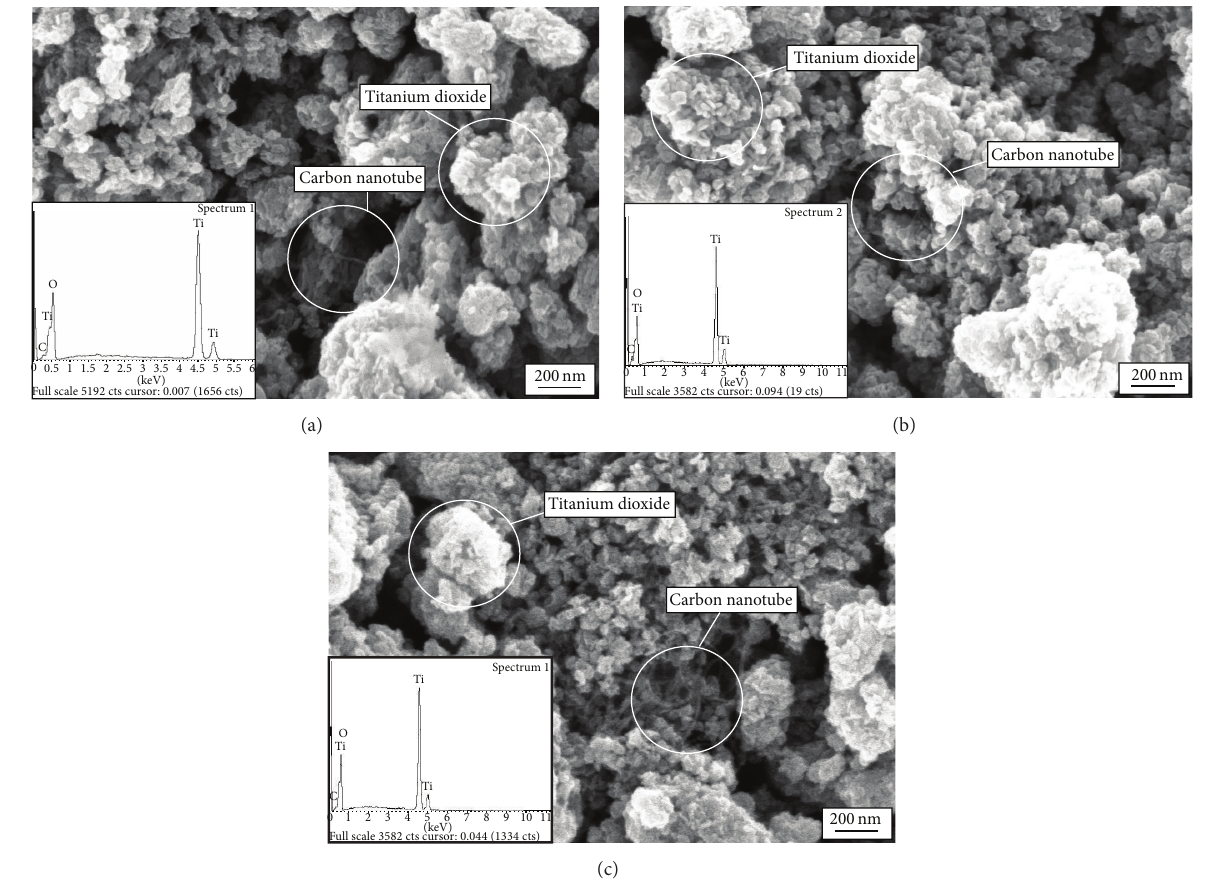
Figure 4: FESEM images of CNT/TiO 2 thin films annealed at different temperatures: (a) 550 ∘ C, (b) 650 ∘ C, and (c) 750 ∘ C.